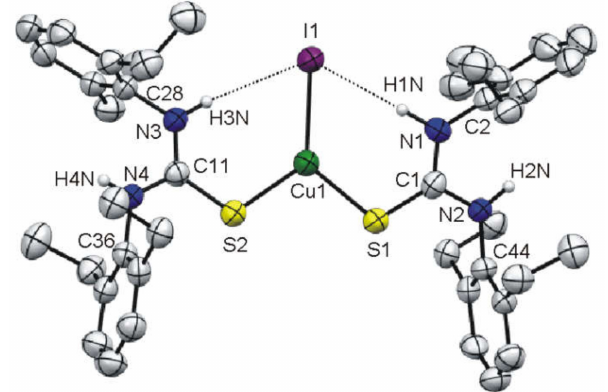
Figure 5. Molecular structure of 1c (ellipsoids correspond to the 50% probability level). All hydrogen atoms, except those of N-H hydrogens and one molecule, have been deleted for clarity. Selected bond lengths (Å) and angles ( ◦ ): I1–Cu1 2.5134(8), Cu1–S2 2.2197(15), Cu1–S1 2.2328(15), S1–C1 1.681(6),